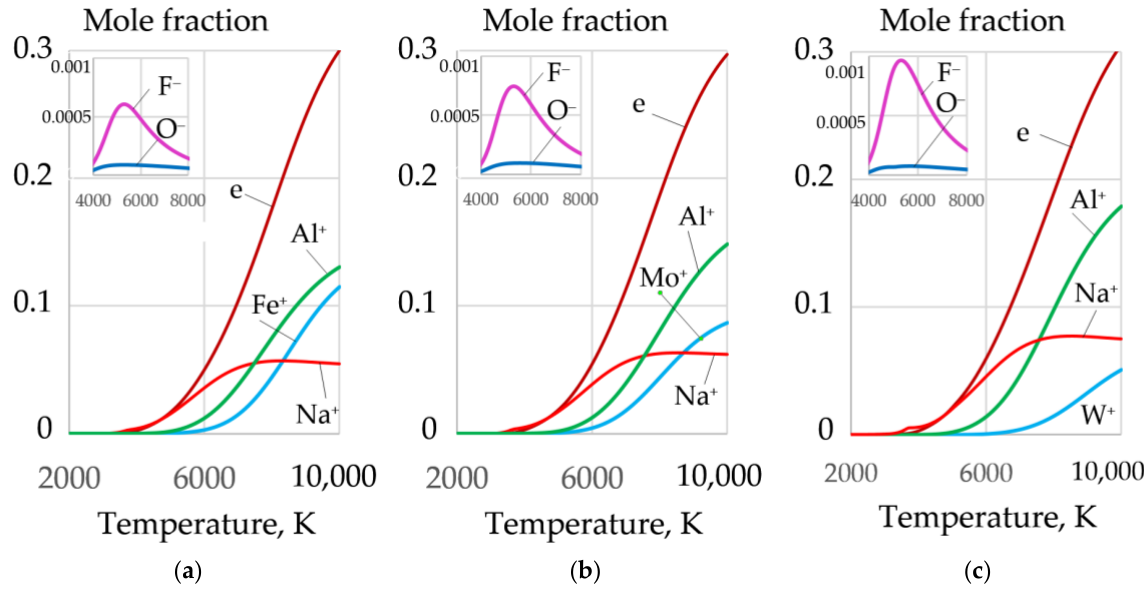
Figure 13. Mole fractions of electrons and ions in the system, wt.%: ( a ) 60Fe 3 O 4 + 20Al + 20Na 3 AlF 6 ; ( b ) 60MoO 2 + 20Al + 20Na 3 AlF 6 ; ( c ) 60WO 2 + 20Al + 20Na 3 AlF 6.